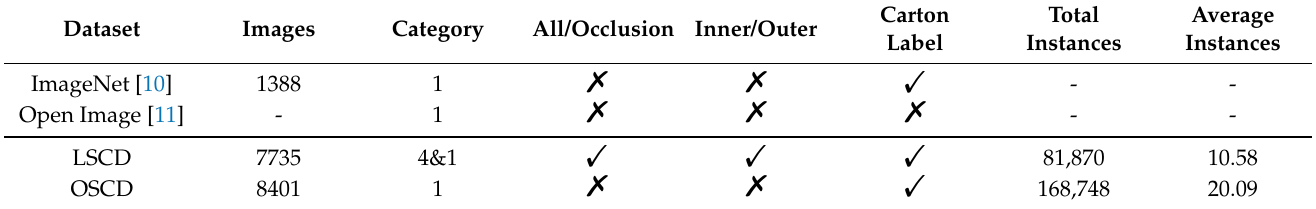
Table 1. The comparison of datasets including the category of carton. “Category” represents the number of carton class. “4&1” in the LSCD column represents that it supports all four categories (Carton-inner-all, Carton-inner-occlusion, Carton-outer-all, and Carton-outer-occlusion) and one category (Carton) manners. Only LSCD supports occlusion information and inner/outer information by giving related annotations. “Images” means the number of images containing carton. “-” means the corresponding dataset only includes the category of box where carton only appear in images but the exact labels are not given in Open Image with too much noise for ImageNet to calculate the number of instances. “Average Instances” represents the average number of instances in each image. The checkmark represents the dataset contains the corresponding annotation while cross mark represents it does not contain.